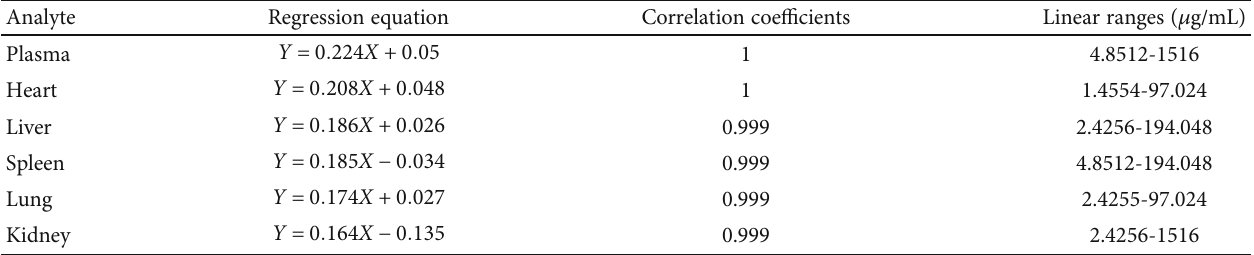
Table 1: Regression equations, correlation coe ffi cients, and linear ranges of BA in mouse plasma and tissues. Analyte Regression equation